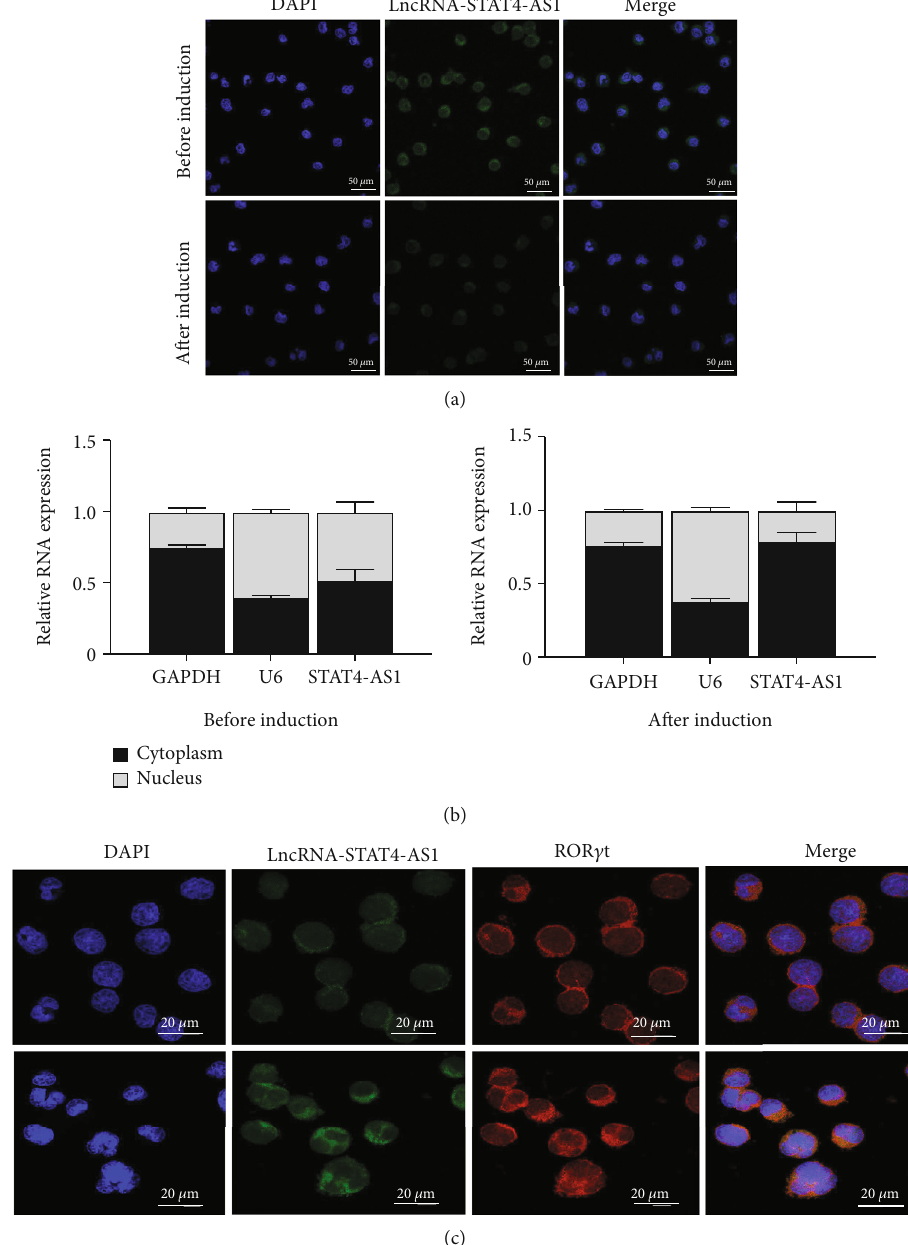
Figure 6: Subcellular localization of lncRNA STAT4-AS1 ( n = 3 ). (a) The localization of lncRNA STAT4-AS1 in PBMCs cells before and after induction was determined by FISH. (b) Nuclear-cytoplasmic separation assay. (c) The colocalization of lncRNA STAT4-AS1 and ROR γ t protein in TH17 before and after overexpression of lncRNA STAT4-AS1 was determined by FISH and immuno fl uorescence. Three independent experiments were performed, and data are presented as the mean ± SD . ∗ p < 0 : 05 , ∗∗ p < 0 : 01 , and ∗∗∗ p < 0 : 001